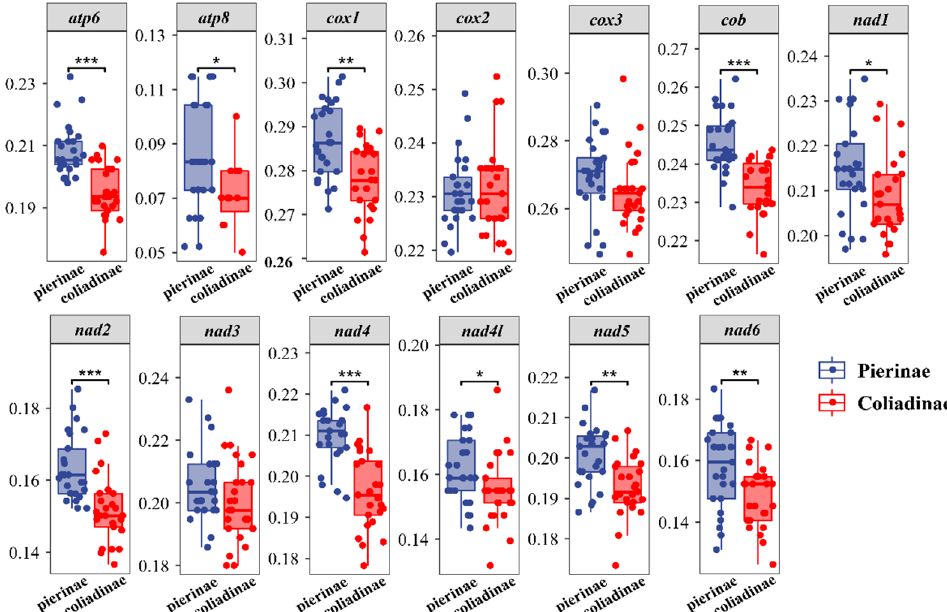
Figure 3. Wilcoxon rank-sum test comparison of GC contents of 13 mitochondrial protein-coding genes between the subfamilies Coliadinae and Pierinae (* denotes p ≤ 0.05; ** denotes p ≤ 0.01; *** denotes p ≤ 0.001).